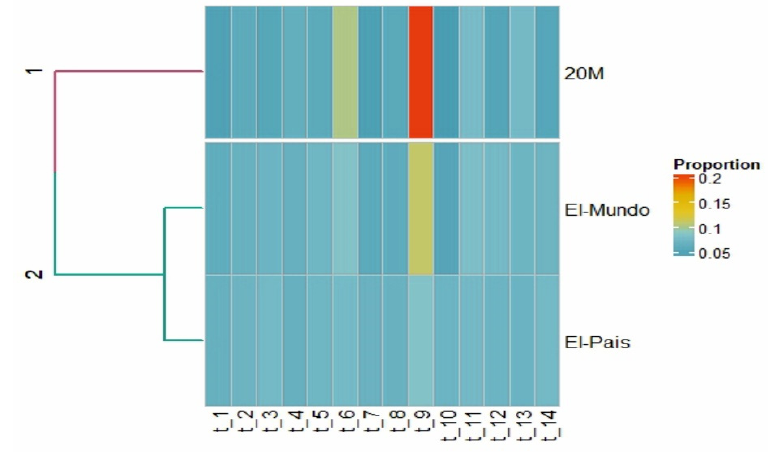
Figure 5. Heatmap of the obtained LDA.